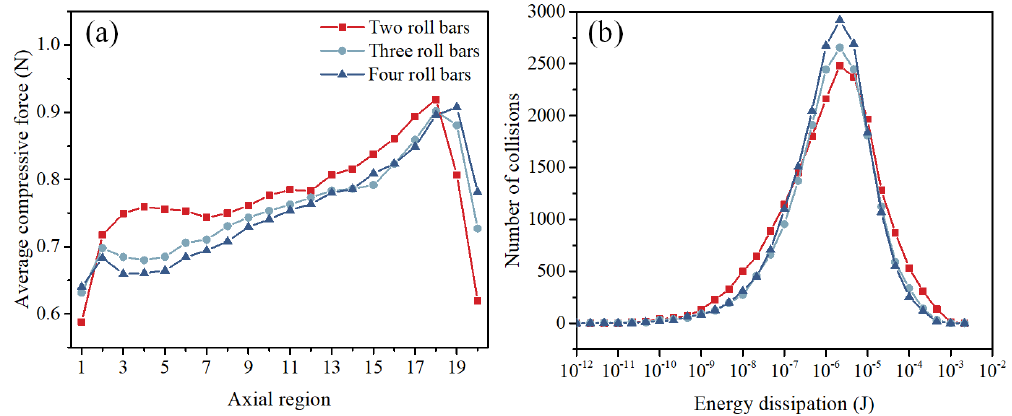
Figure 10. (a) Average compressive force under different numbers of convex ribs. (b) The distribution of energy dissipation during the particle